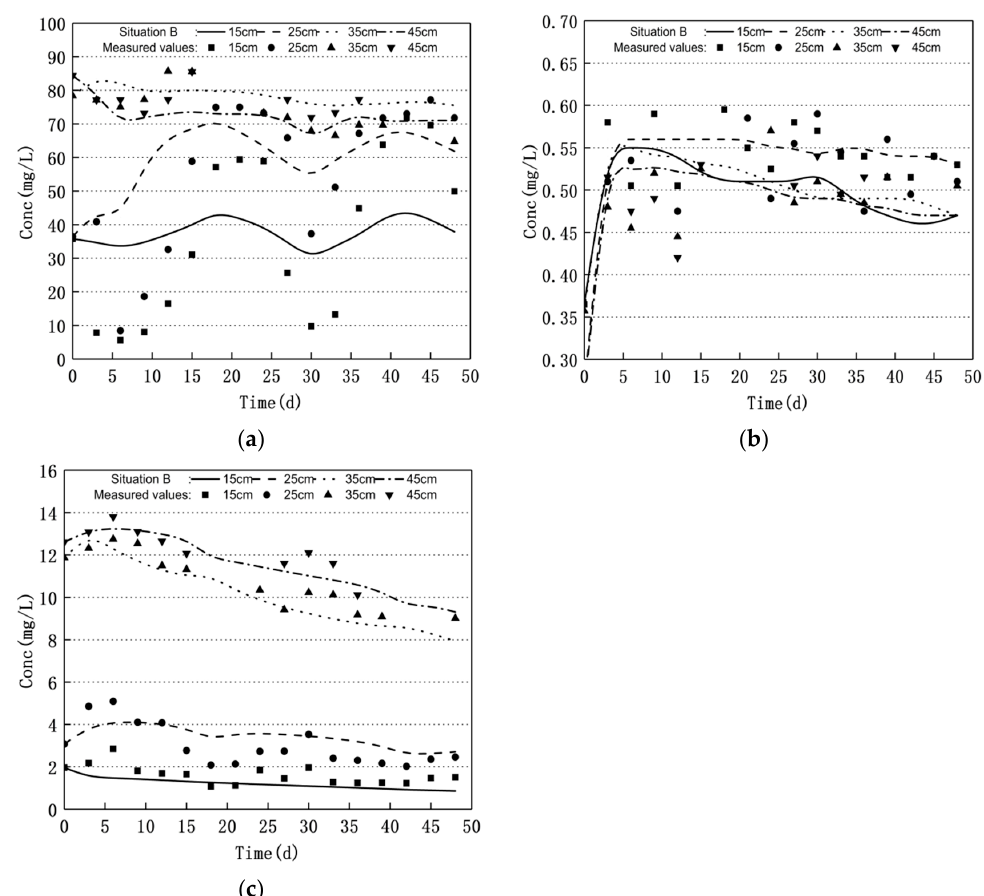
Figure 12. The measured results of coarse sand and the process of dynamic change of nitrogen in